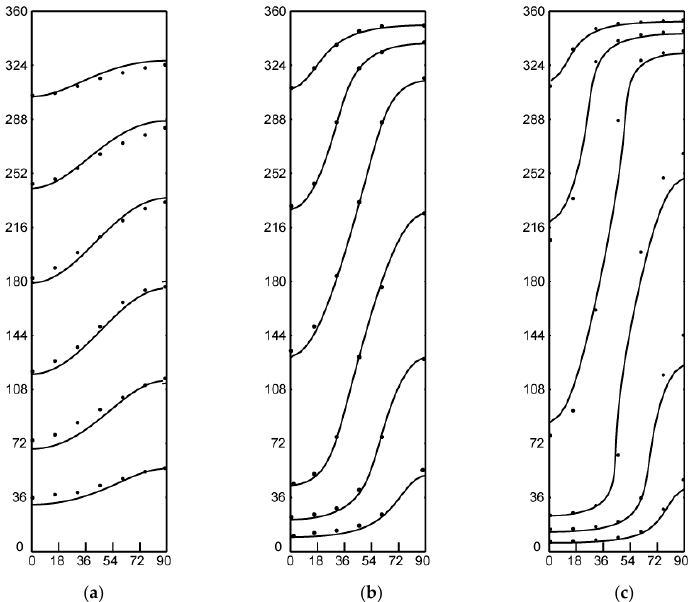
Figure 4. Steady state streamfunction patterns for the first application (Ra = 200): ( a ) Case 1; ( b ) Case 2; and ( c ) Case 3.